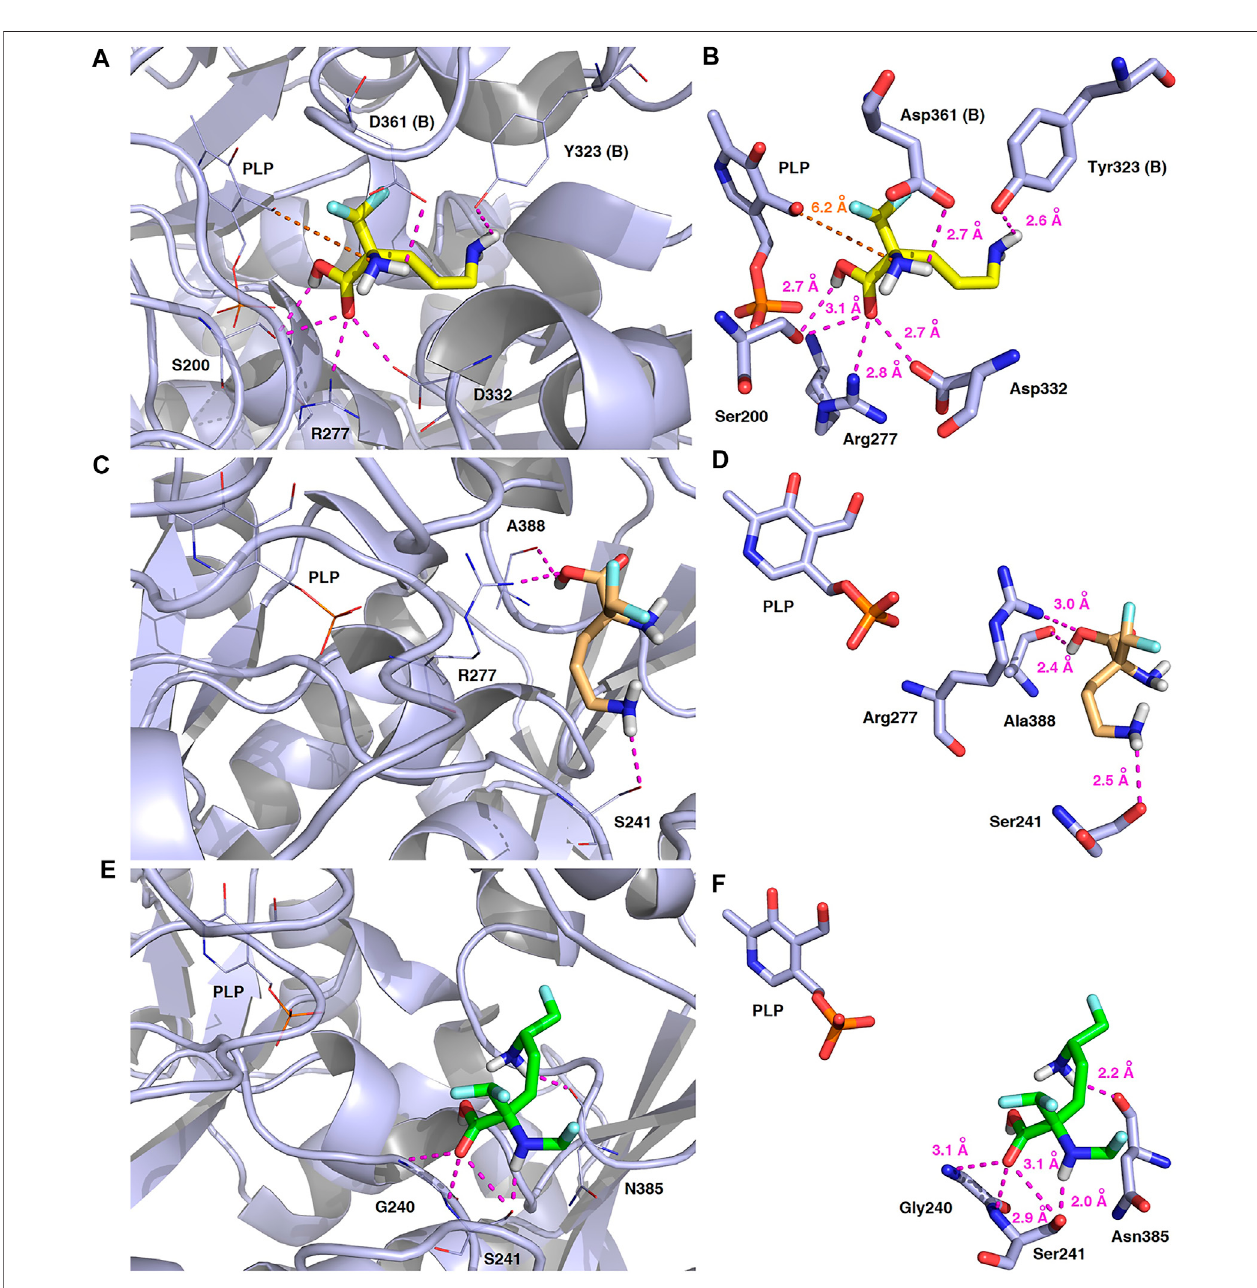
FIGURE 14 | Three-dimensional model of the representative binding modes of L -DFMO (A,B) , D -DFMO (C,D) , and the DFMO-analogue (E,F) to human ornithine decarboxylase complexed with PLP-cofactor (h-ODC, PDB ID: 2OO0) (Dufe et al., 2007) with close contacts to residues in the active site. All six panels (A – F) show inhibition of h-ODC by blocking substrate-binding site through direct interaction of the ligands with critical amino acids of the receptor in catalytic cavity. Ligands are shownasstickscoloredinyellow( L -DFMO),gold( D -DFMO)orgreen(DFMO-analogue),respectively.Theoverallenzymestructureisshownasalightbluecartoon diagram (see A,C,E ). The most signi fi cant amino acid residues contributing to the stabilization of the ligand molecules in the complex with h-ODC by polar interactions and by CH – CH van der Waals (vdW) interactions are shown in light blue sticks (see B,D,F ) representations. Nitrogen atoms are presented in blue, oxygen atoms in red, fl uorine atoms in pale cyan, phosphorus atoms in orange, whereas hydrogen atoms (attached to nitrogen and/or oxygen atom of the carboxylic group) in gray. The mutual distances between the amino acid residues (and PLP-cofactor) and the respective ligands ’ atoms are given in Ångstro ̈ m (see B,D,F ). The formation of intermolecular hydrogen bonds is represented by magenta dashed lines. Orange dashed lines represent distances between the α -amino group of L -DFMO and the carbon atom of the formyl group present in the PLP-cofactor.